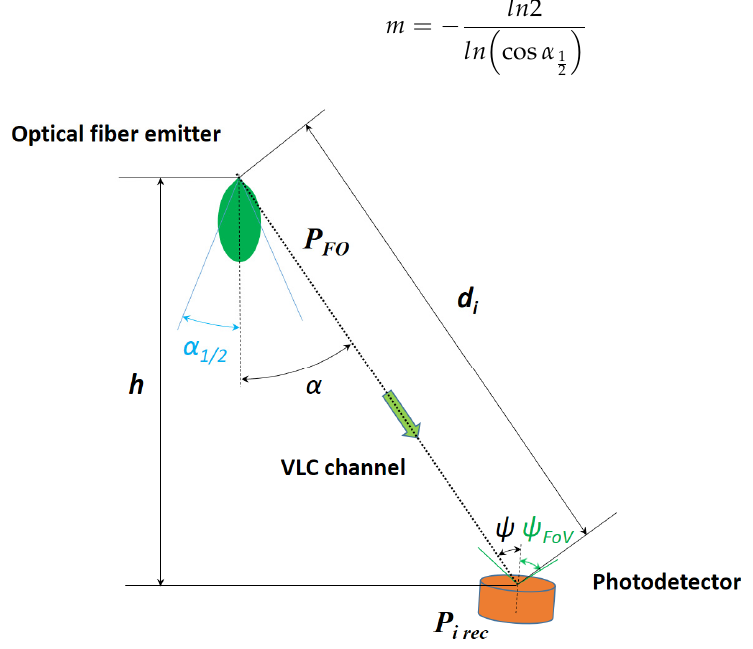
Figure 6. Schematic for the DC-gain estimation for VLC channel.